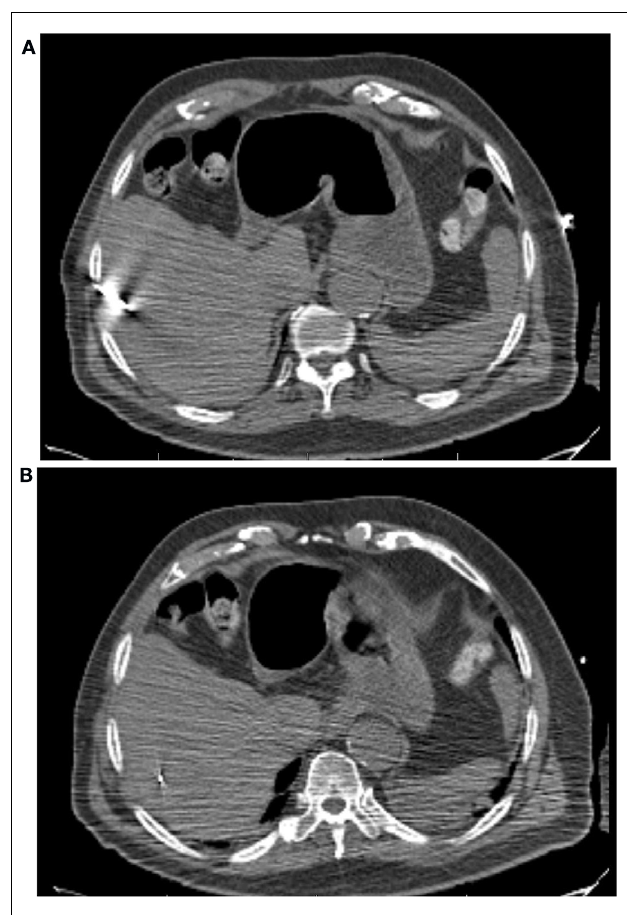
FIGURE 1 | (A) Fiducial placement, (B) fiducial